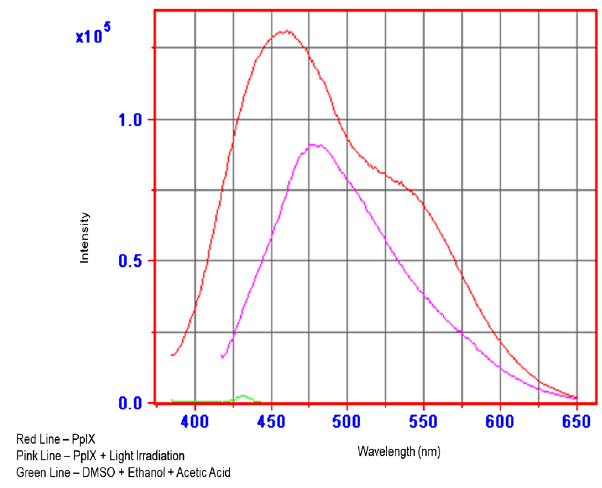
FIGURE 1 - Spectrofluorometry analysis of PpIX. The red line represents bacteria + ∂ -ALA incubated for 13 min. The presence of PpIX after the exogenous administration of ∂ -ALA was demonstrated. The pink line represents bacteria + ∂ -ALA + laser irradiation (200 J/cm 2 ). A decreased of the signal of PpXI after laser activation was shown. The results are the mean of the